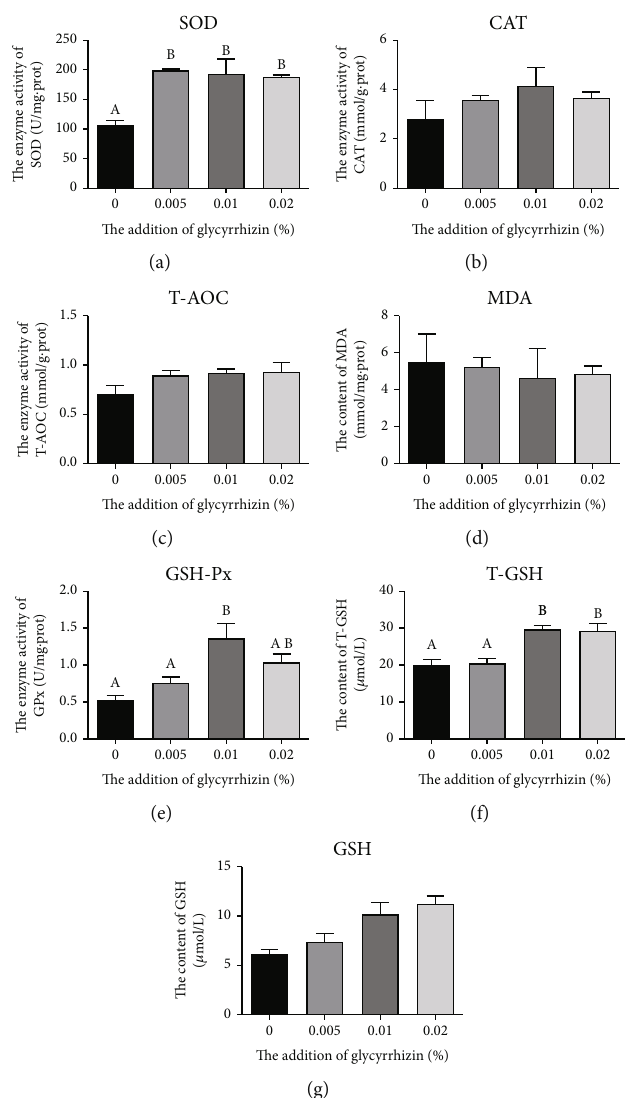
Figure 2: Activities of SOD, CAT, T-AOC, concentration of MDA, activities of GSH-Px, content of T-GSH, and GSH in visceral mass of large yellow croaker larvae. (a) SOD: superoxide dismutase; (b) CAT: catalase; (c) T-AOC: total antioxidant capacity; (d) MDA: malondialdehyde; (e) GSH-Px: glutathione peroxidase; (f) T-GSH: total glutathione; (g) GSH: glutathione. Values are means ( n = 3 ), with their standard errors represented by vertical bars. Bars bearing the same or no letters were not signi fi cantly di ff erent determined by Tukey ’ s test ( P > 0 : 05